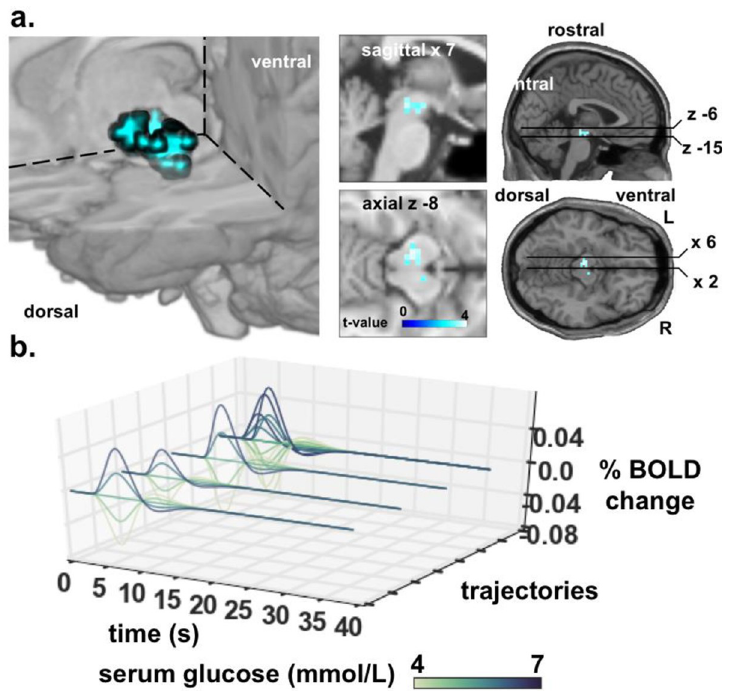
Fig 4. Statistical parametric maps of RPE neg � state subtracted for increasing minus decreasing. a, negative reward prediction error RPE neg � state revealed glucose modulated activity in SN [ ± 12, -22, -10] and VTA [0, –15, –9] when subtracting the effect of descending from the ascending glucose state [FWE SVC]. b, fitted response ( β = 0.34) of the local maxima of cluster [7, -11, 8; 52 voxels] to the three possible trajectories that RPE neg � state yield modulated by serum glucose state. Onsets are not at zero because the negative trajectories do not envelop the trial mean which has a positive expectation. In order of closeness to the viewer, the first set of trajectories is for the Cue high - Outcome gluc trial; the second set is for the Cue high − Outcome water trial; the third set is for Cuelow − Outcome gluc trial; the fourth set is for the Cuelow − Outcome water trial. The fifth set of trajectories (furthest from the viewer) superimpose together all possible trajectories depicting the complexity of how the trajectories are patterned according to their modulation by glucose state. The set of trajectories furthest away from the viewer superimposes the trajectories from all trial types into one plot.